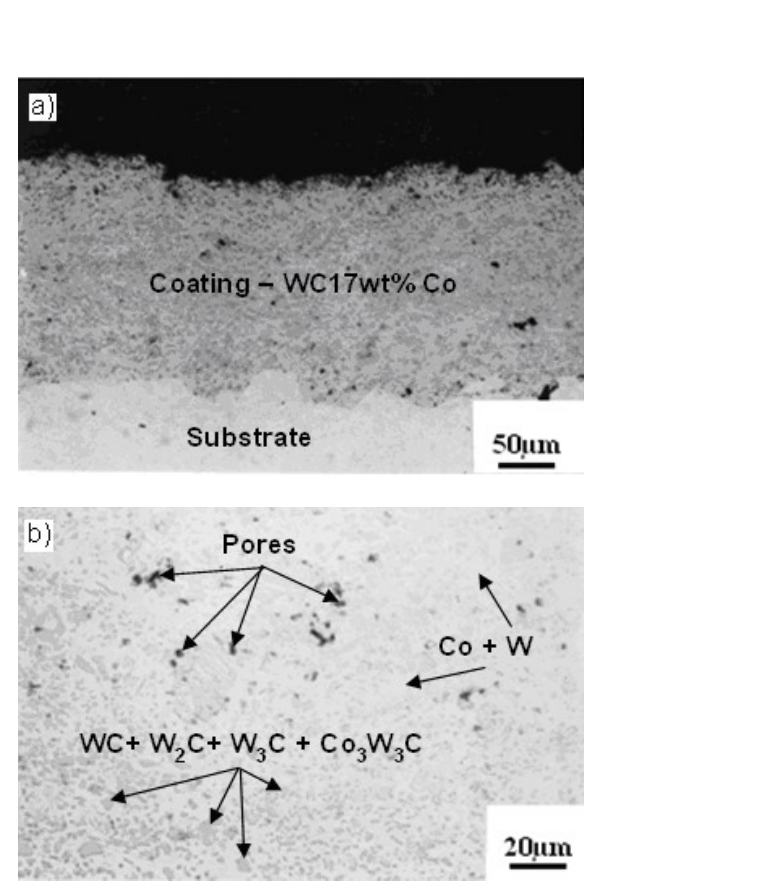
Figure 7 – Microstructure of the WC17Co coating with a plasma gas flow of 32 l / min.He (a) substrate / coating interface and (b) middle layer Slika 7 – Mikrostruktura prevlake WC17Co sa protokom plazma gasa 32 l/minHe, (a) interfejs substrat/prevlaka i (b) sredina